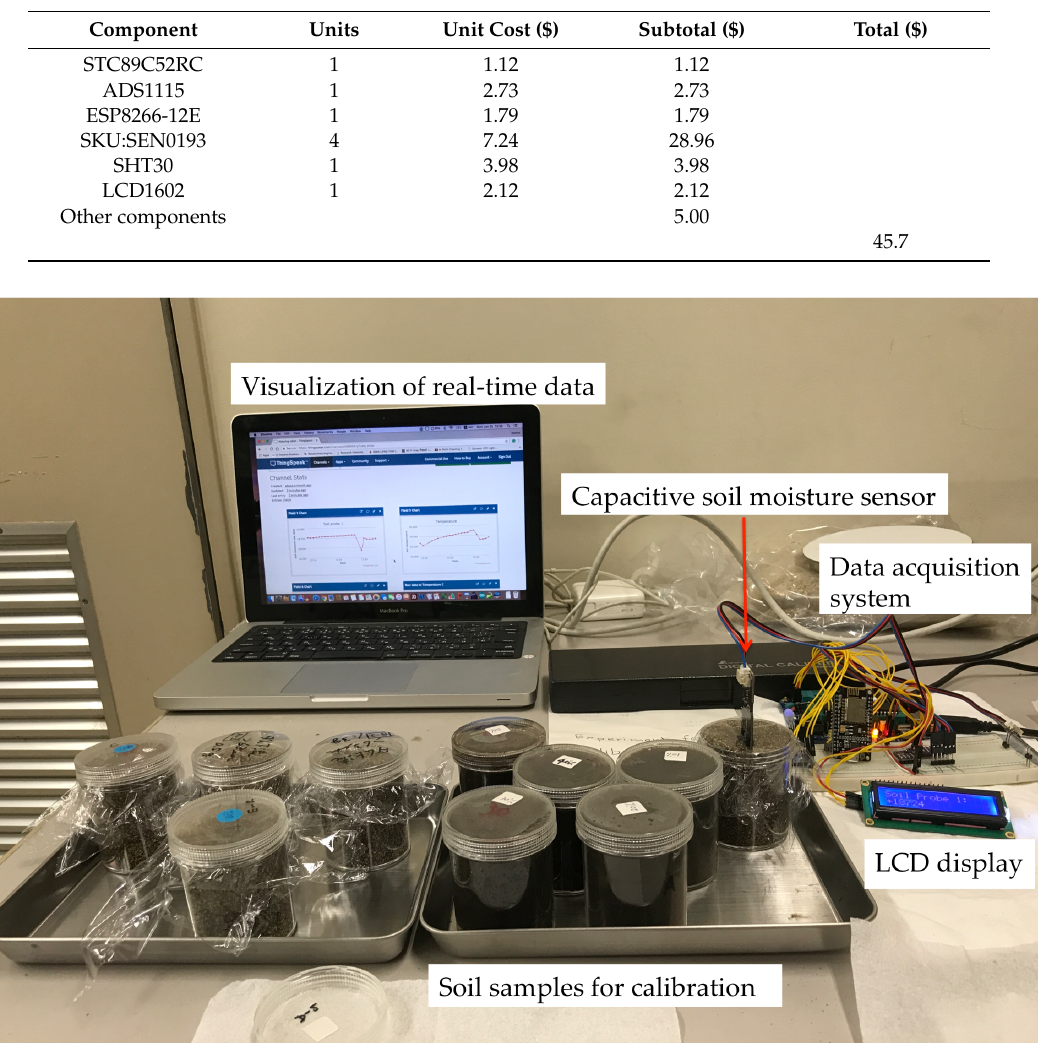
Figure 1. Acquisition and visualization of real-time data during the soil sample calibration